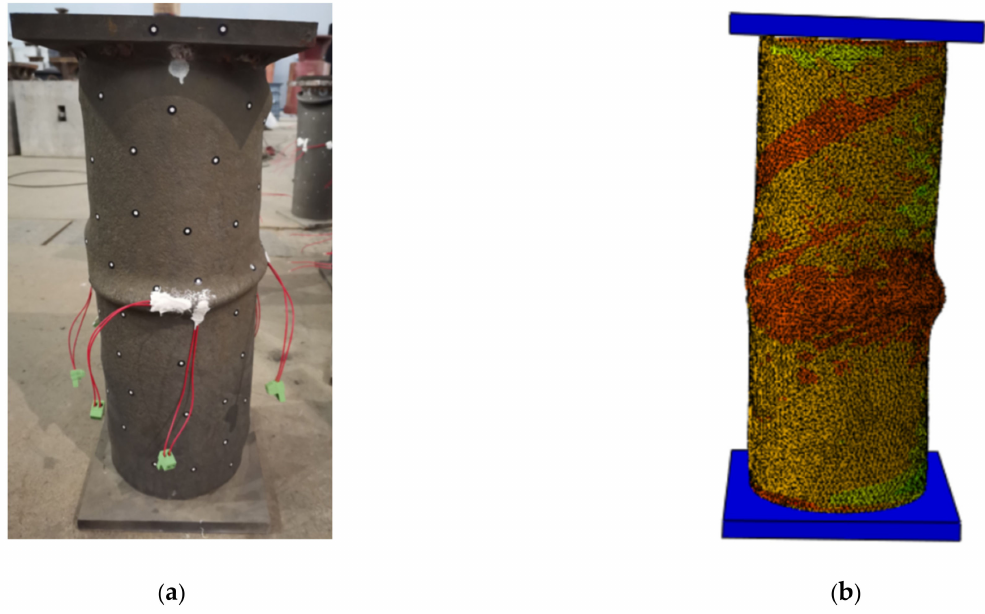
Figure 9. Comparison of failure mode of specimen CT90C35A: ( a ) test observed deformation; ( b ) FEA analysis deformation. Table 5. Ultimate load comparison between test results and FEA